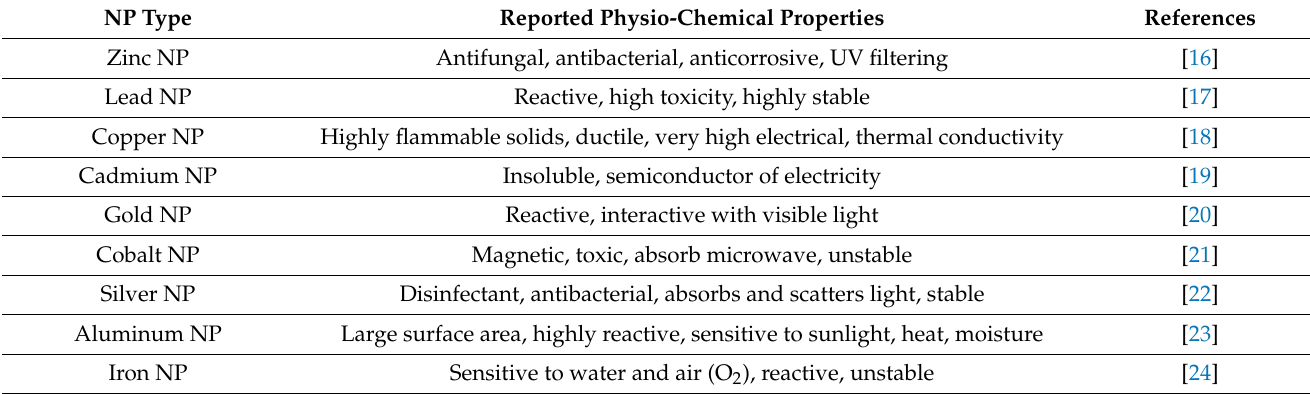
Table 1. Classification of metal NPs and their physio-chemical properties.